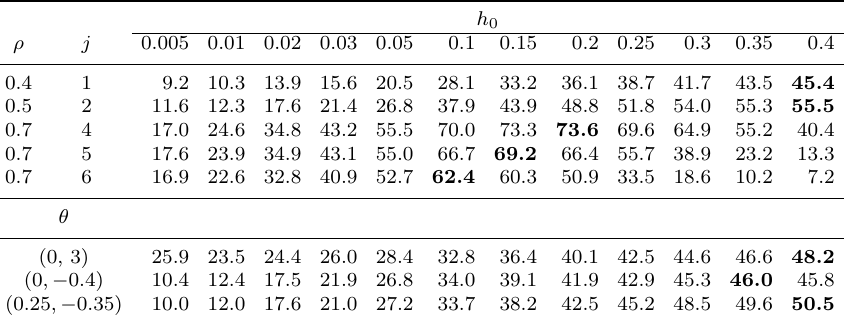
Table 3. Independent case. Simulated power of T n for alternatives g 1 and g 2 with n = 50 and 10,000 replications; h = h 0 n − 1 / 4 , kernel U [ − 1 , 1].